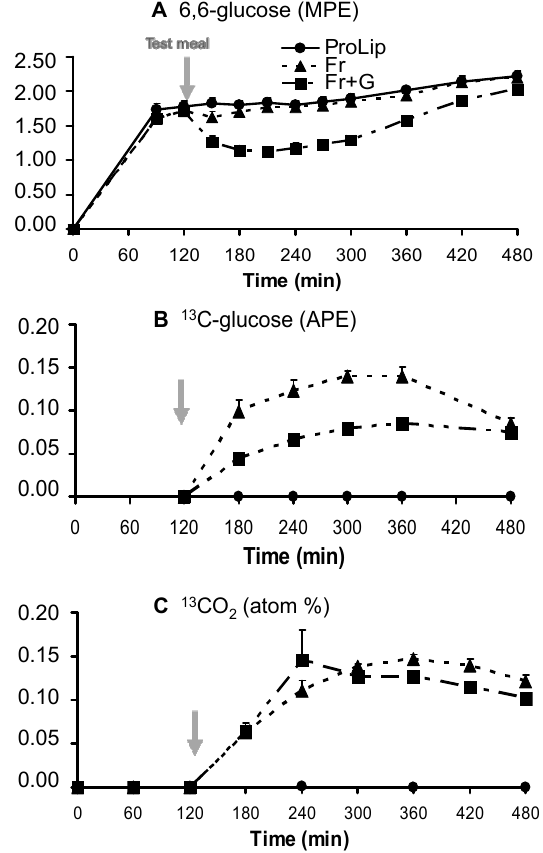
Figure 4. Plasma 6,6- 2 H -glucose ( A ), plasma 13 C-glucose ( B ) and breath 13 CO 2 isotopic enrichments. (Mean ± SEM, n = 8). Test meals were given at t = 120 min. MPE: molar percent excess; APE: atom percent